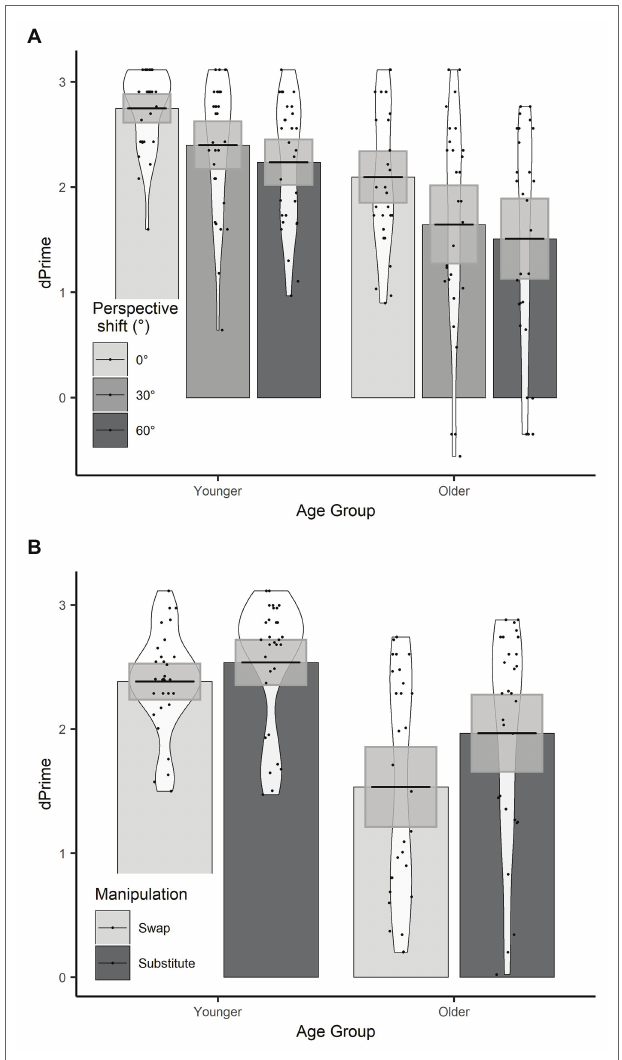
FIGURE 4 | (A) d ’ scores for age group × perspective; (B) d ’ scores for age group × manipulation. Plots show mean averages with confidence interval error bars, individual data points, and density